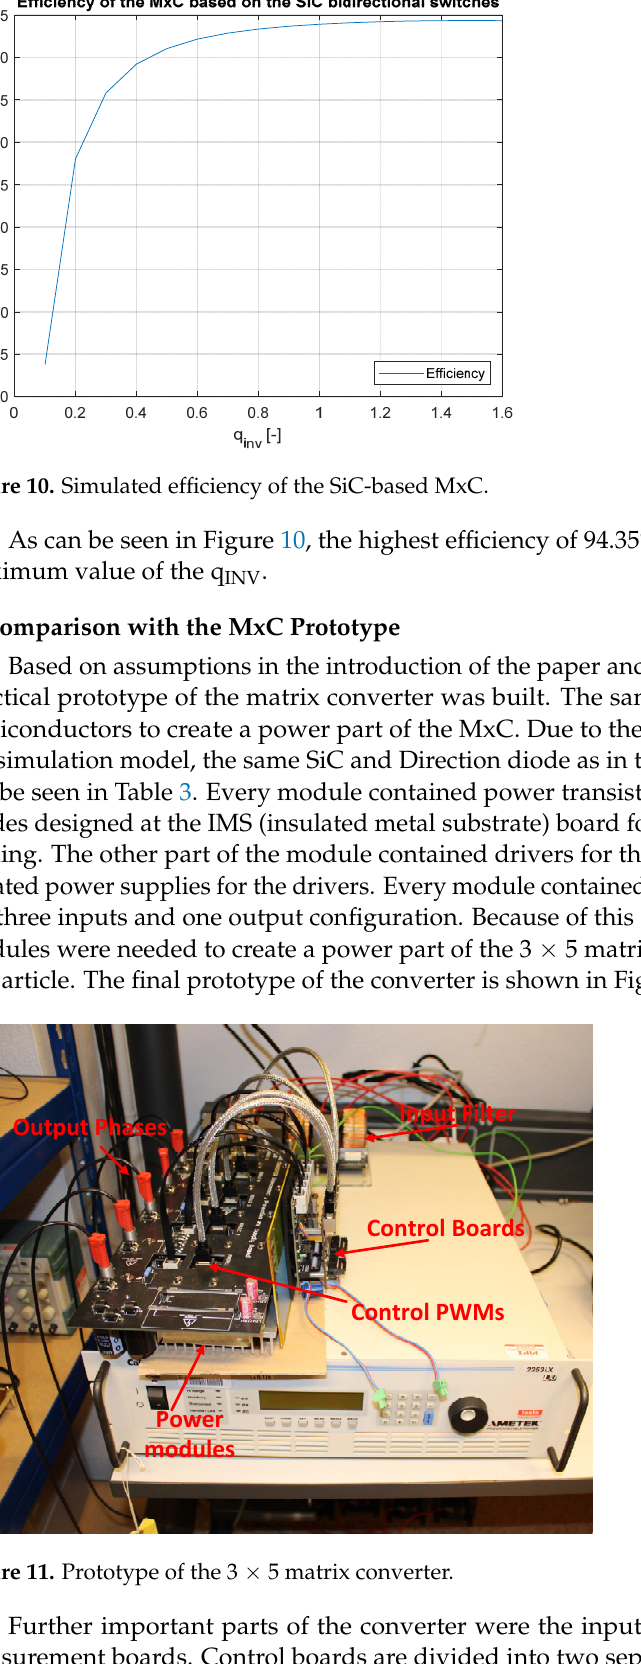
Figure 9. Output powers of the simulation models.